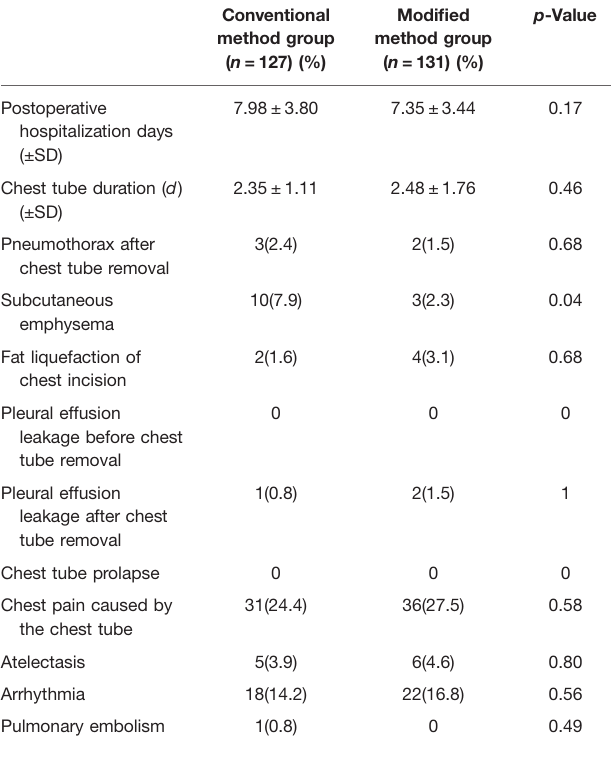
TABLE 2 | Comparison of outcomes between two